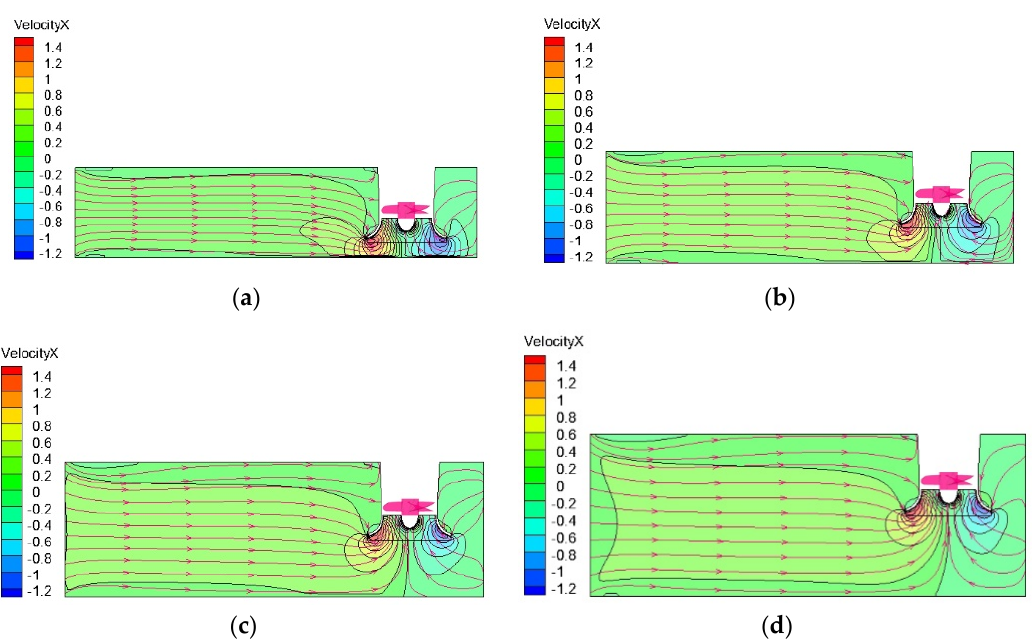
Figure 18. Velocity distribution of section 1-1 with different floor clearance. ( a ) Case 11, ( b ) Case 6, ( c ) Case 12 and ( d ) Case 13.